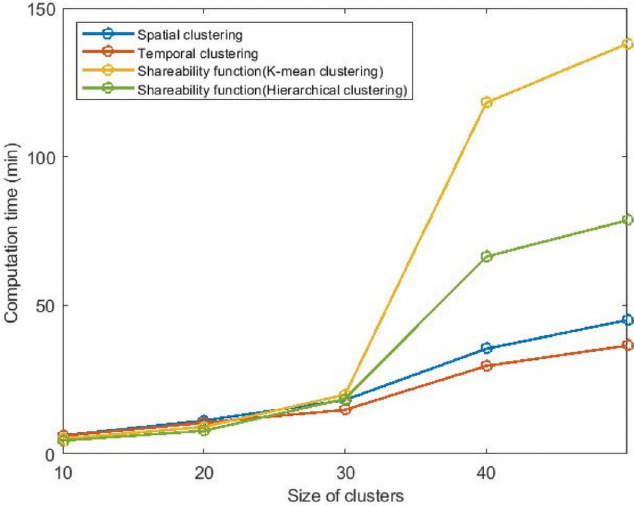
Fig 11. Comparing clustering methods’ computation time (market-share =